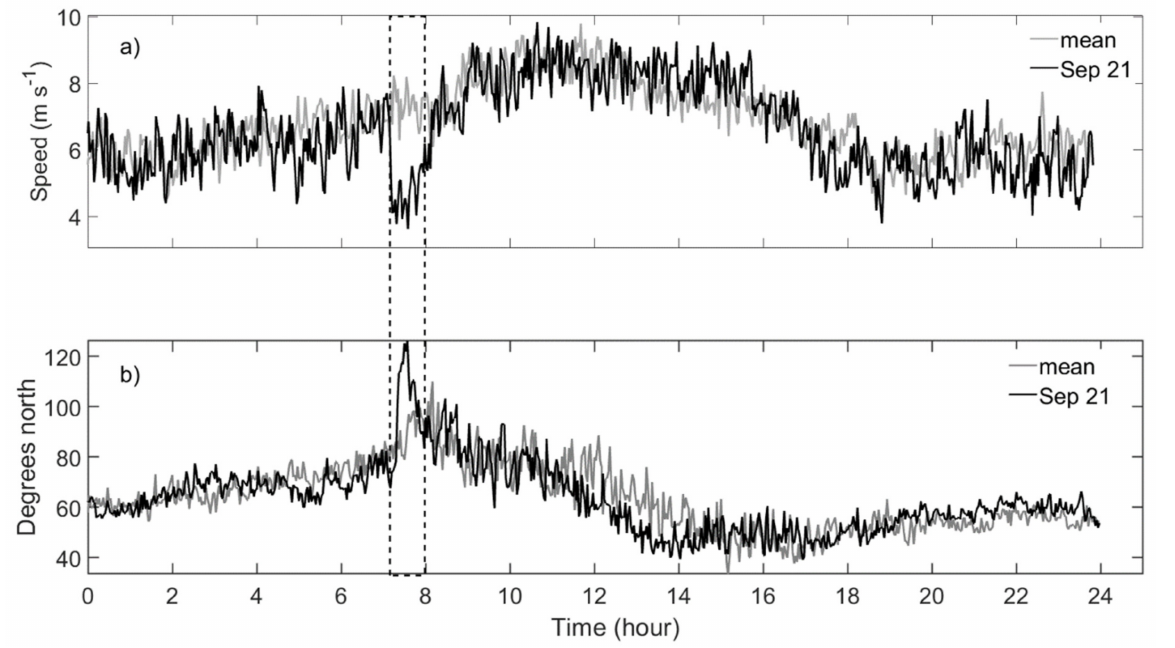
Figure 11. Diurnal variability of the vertically averaged wind speed ( a ) and wind direction ( b ). Tower anemometers at 3, 5, 7, and 10 m were used for the vertical averages. A black line illustrates the time series for 21 September, with two vertical dashed lines indicating the meteorological phenomenon of interest (21 September, between 07:00 h and 08:30 h LT). A gray line represents the expected daily wind behavior (computed for 24 h with 1 min time resolution).